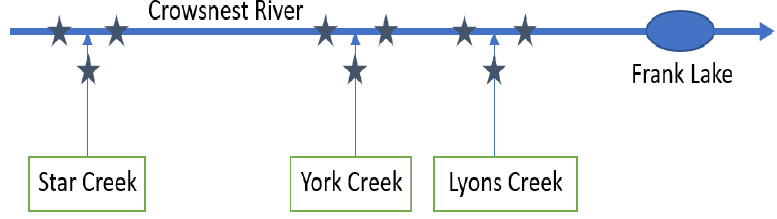
Figure 6. A schematic diagram of the sampling sites in the upper Crowsnest River.